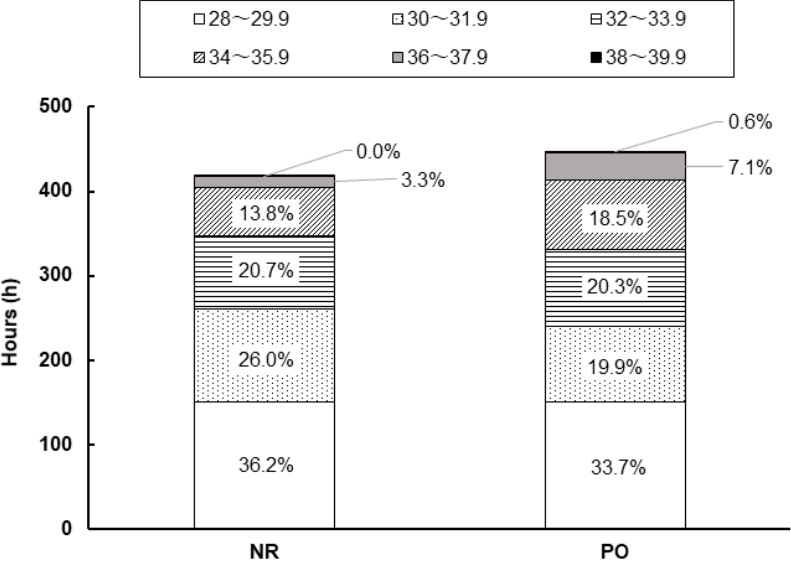
Figure 3. The cumulative hours of air temperature above 28.0 ◦ C and the ratio of each air temperature hour to that of cumulative hours. NR, NIR reflective film; PO, polyolefin film. Each instantaneous air temperature (recorded every minute) was categorized by every 2.0 degrees from 28.0 ◦ C. The values in the stacked bars are the percentages of each temperature category in the total cumulative hours of air temperature above 28.0 ◦